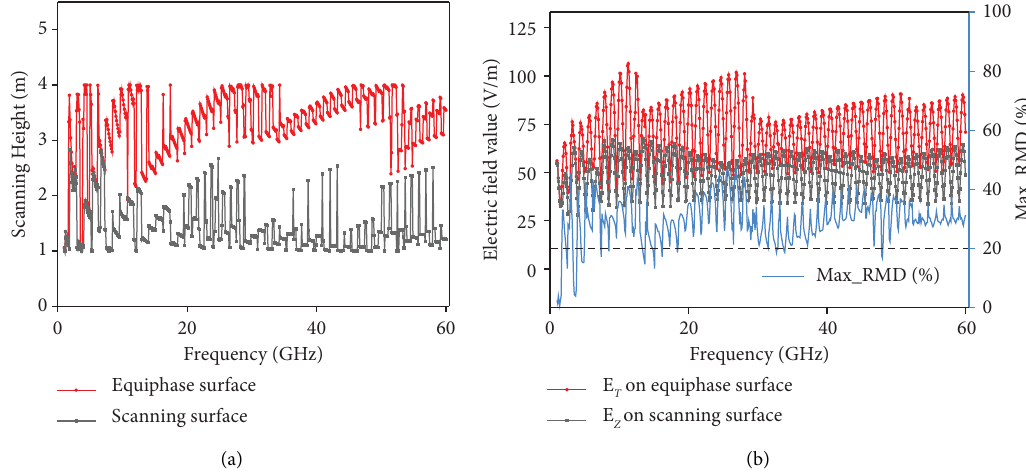
Figure 6: Results of a vertical dipole measured in a SAC: length h � 6U and distance d � 3m. (a) Scanning height corresponding to the maximum electric felds on the two surfaces. (b) Relative deviation of the maximum electric felds on the two surfaces.